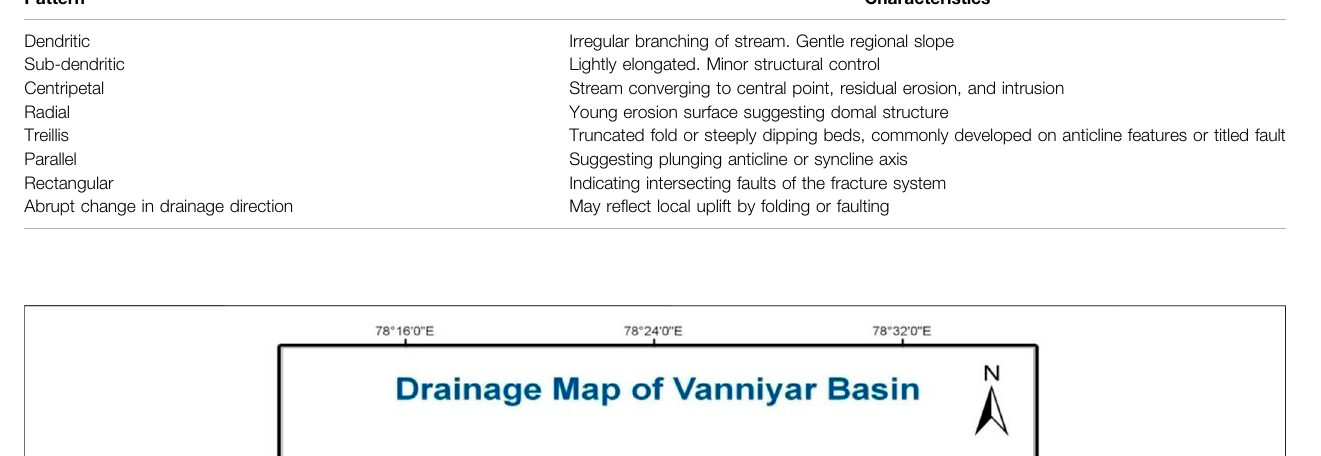
TABLE 3 | Types of drainage and its anomaly used to identify the underlying strata of the Vanniyar basin, Dharmapuri district, Tamil Nadu, India. Pattern